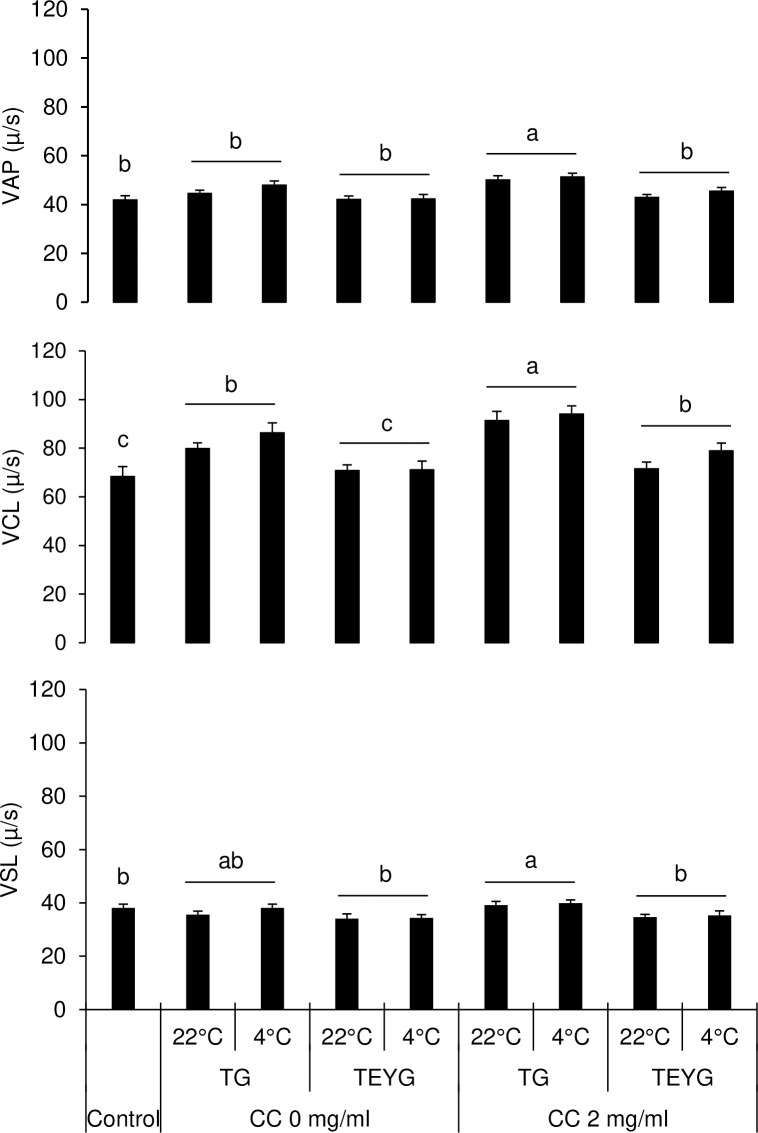
Effect of cholesterol-cyclodextrin complex, extender and temperature of glycerol addition on post-thaw sperm average path velocity (VAP), curvilinear velocity (VCL) and straight-line velocity (VSL).Each bar represents mean±SEM of five pooled ejaculates (replicates) from four bulls. Within a velocity characteristic, bars with different letters (a-c) differ from each other (p < 0.05). Abbreviations: CC, cholesterol-cyclodextrin complex; EY, egg yolk; TG, tris-glycerol extender; TEYG, tris-egg yolk-glycerol extender.